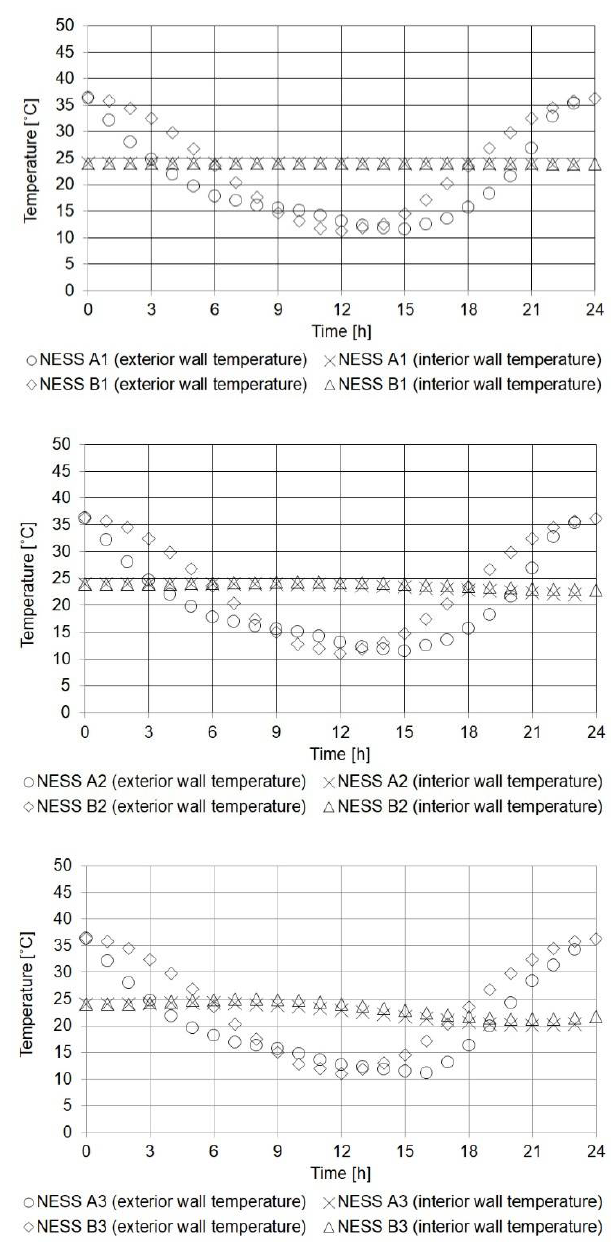
Figure 5. Simulation results for building wall models A and B for non-exposed wall in sunny spring conditions (NESS).